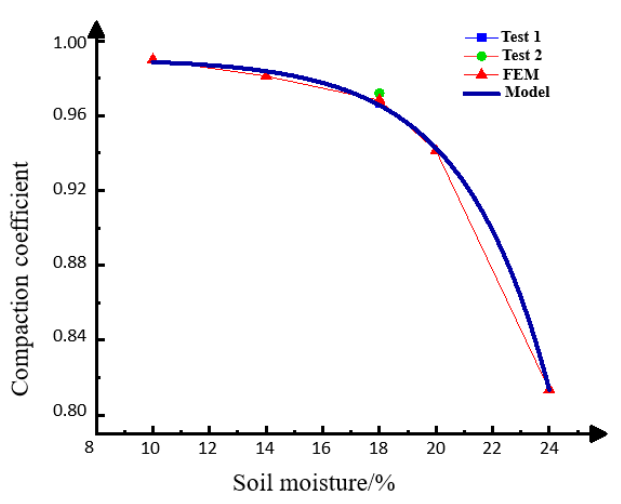
Figure 8. The relationship between the compaction coefficient and ω .